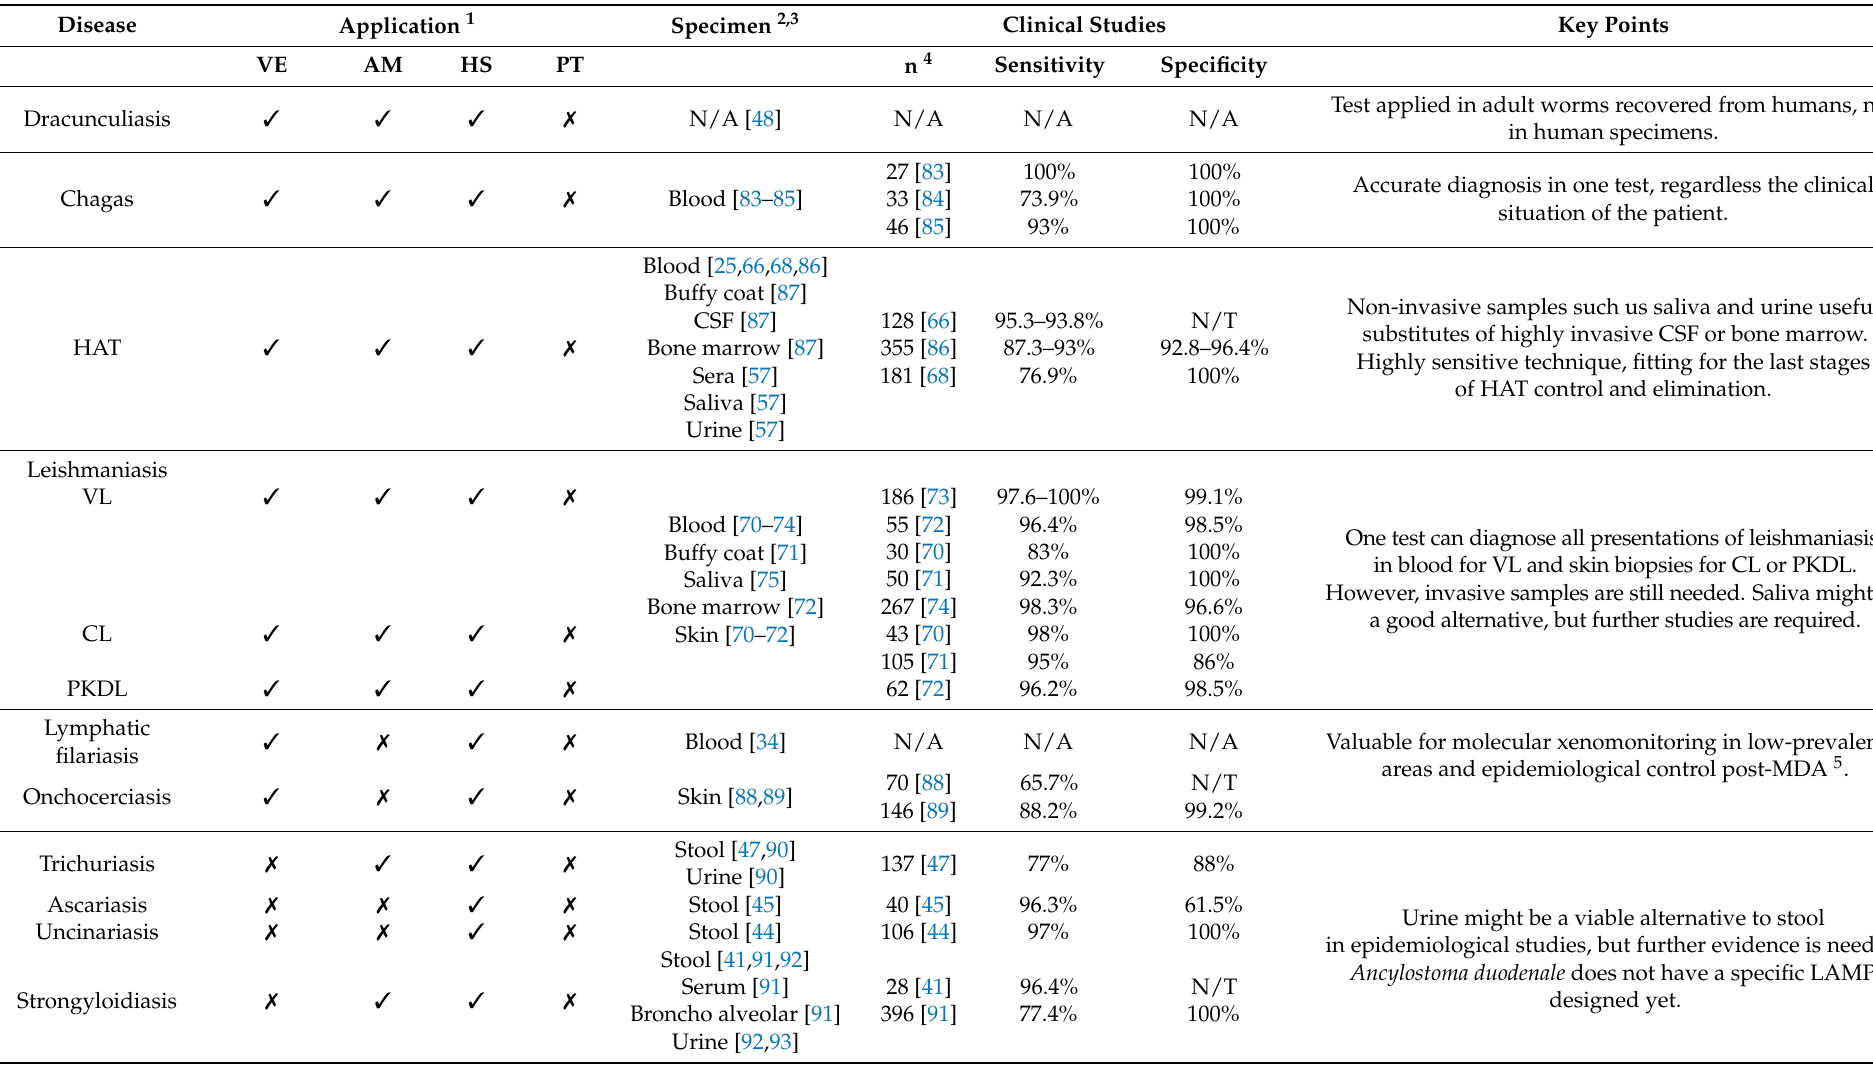
Table 1. Summary of relevant studies of LAMP in parasite-caused